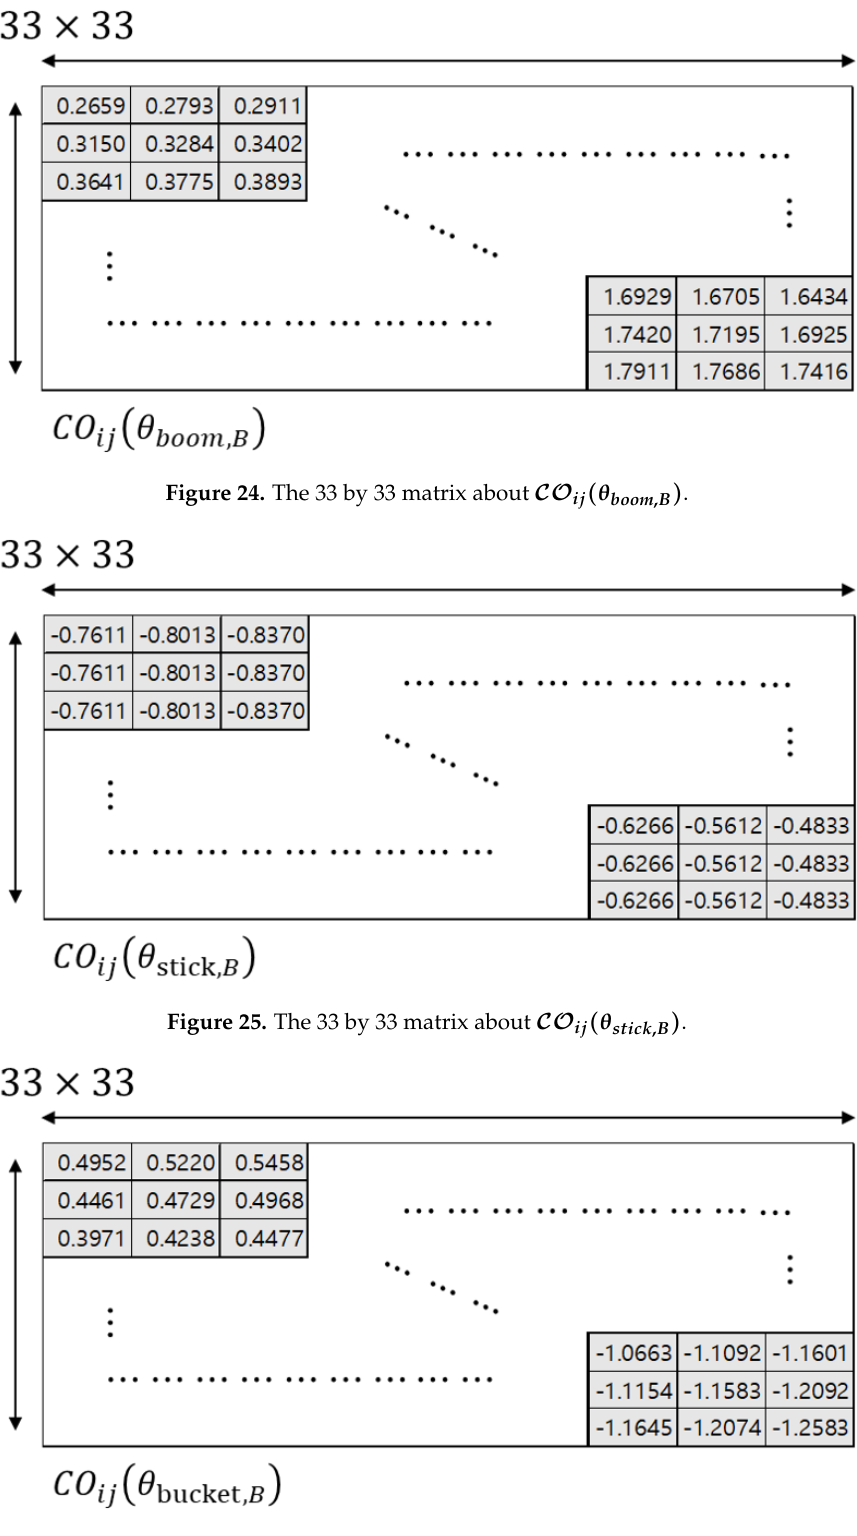
Figure 26. The 33 by 33 matrix about CO ij ( θ bucket , B )